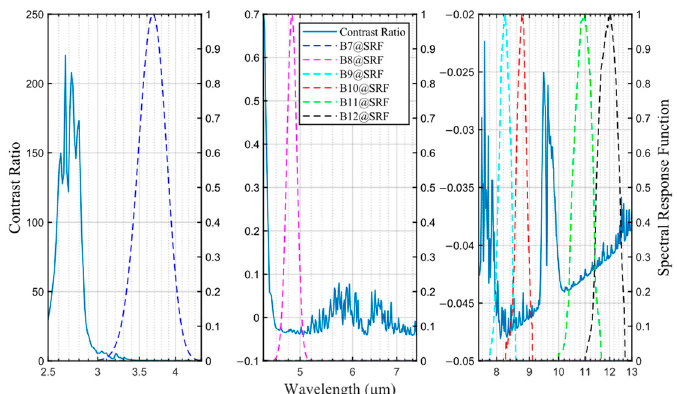
Figure 13. Target-background contrast and the spectral response functions of VIMS B7–12 at the GSD of 120 m. of 120